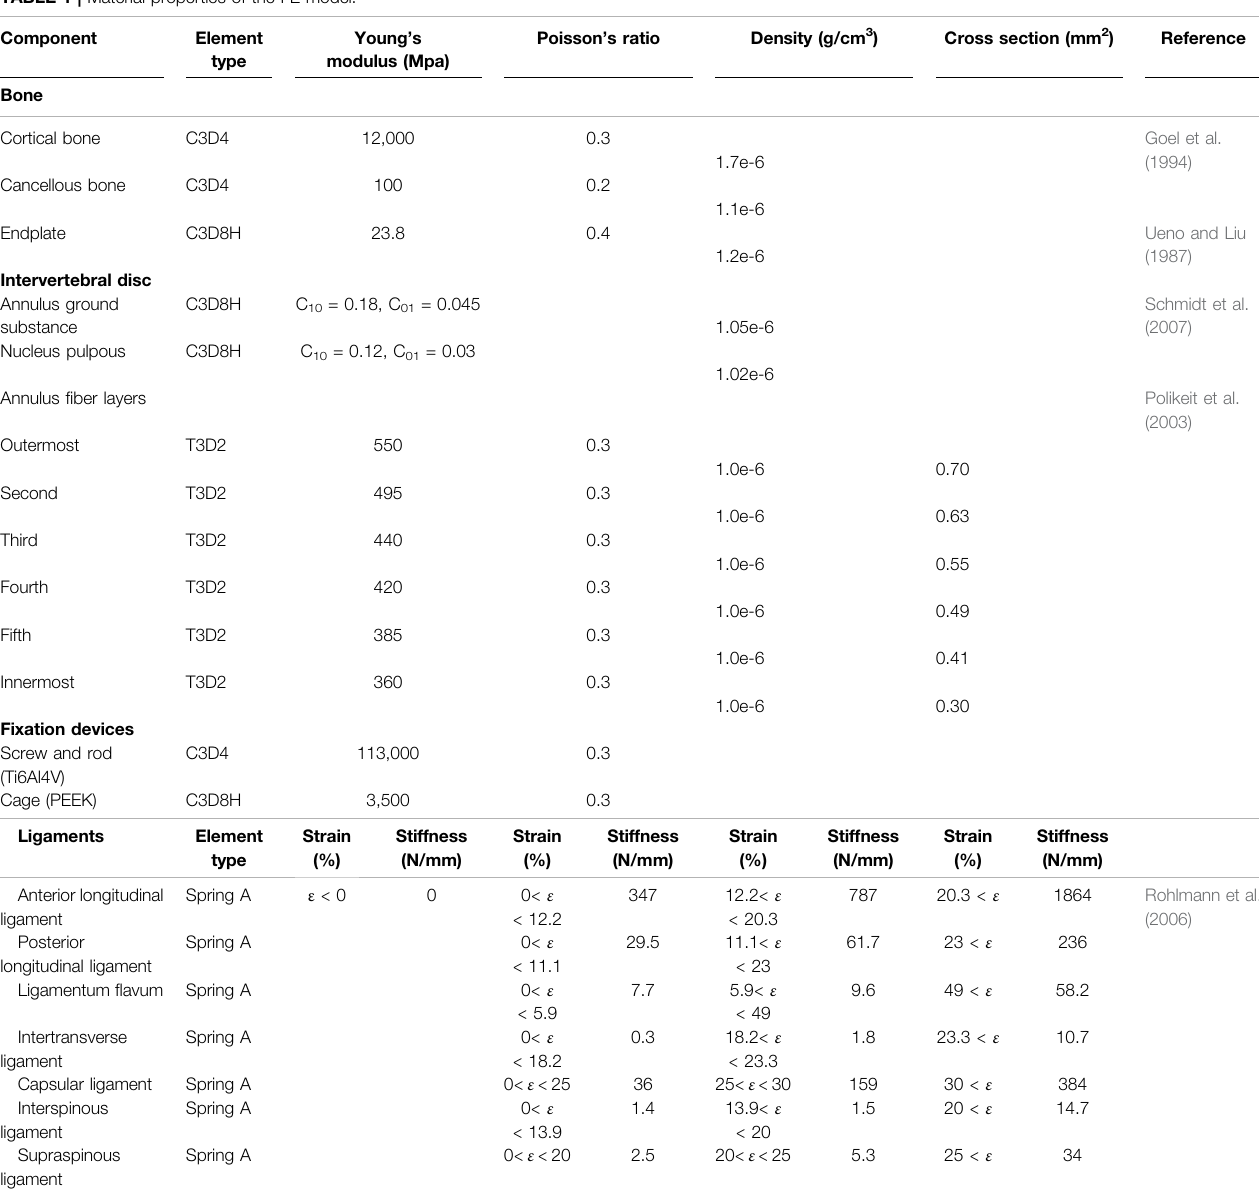
TABLE 1 | Material properties of the FE